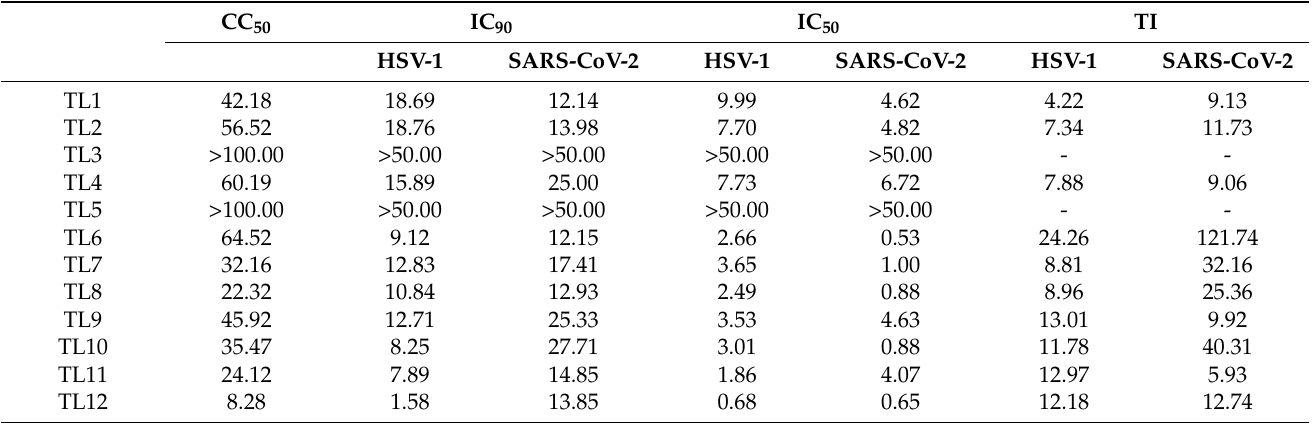
Table 3. CC 50 , IC 90 , IC 50 , and TI calculated for HSV-1 and SARS-CoV-2. Concentrations are expressed in µ M.